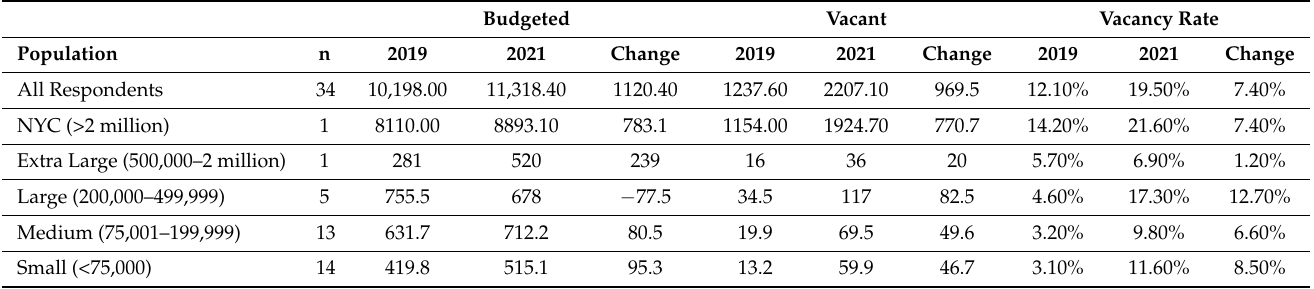
Table 5. Vacancy Rates Among LHDs in NYS (2019 vs.